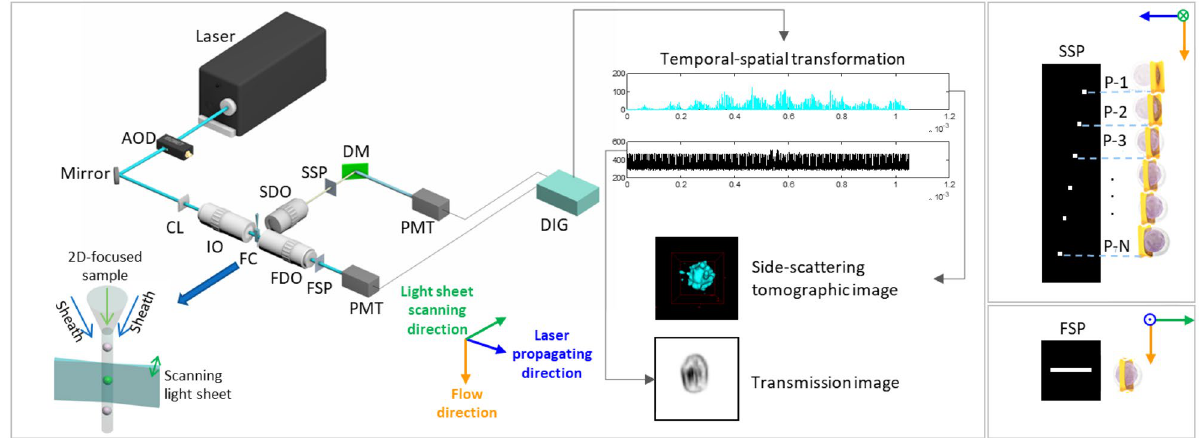
Figure 1. 3D imaging flow cytometer (3D-IFC) dual-modality imaging system. AOD, acousto-optic deflector; CL, cylindrical lens; IO, 20X/0.42NA illumination objective; SDO, 10X/0.28 NA side detection objective;